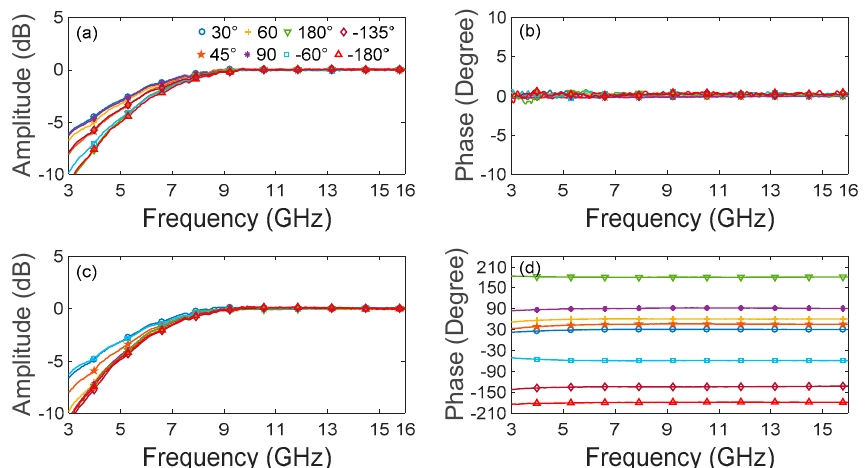
Figure 15. The measured ( a ) S 21 amplitude response, ( b ) S 21 phase response, ( c ) S 41 amplitude response and ( d ) S 41 phase response of the photonics-based microwave hybrid coupler designed to have a 3 dB coupling ratio and a tunable phase. Port 3 of the hybrid coupler was terminated by a 50 Ω terminator.